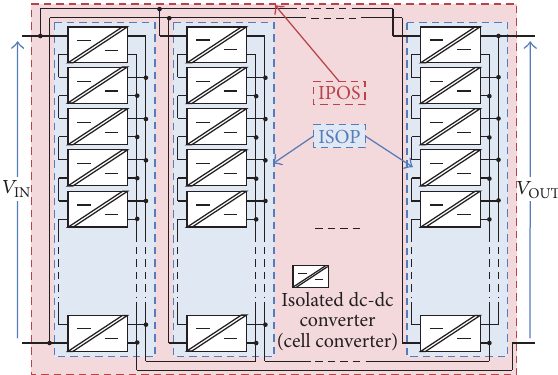
Figure 2: Conceptual diagram of multicell dc-dc converter based on ISOP-IPOS connection